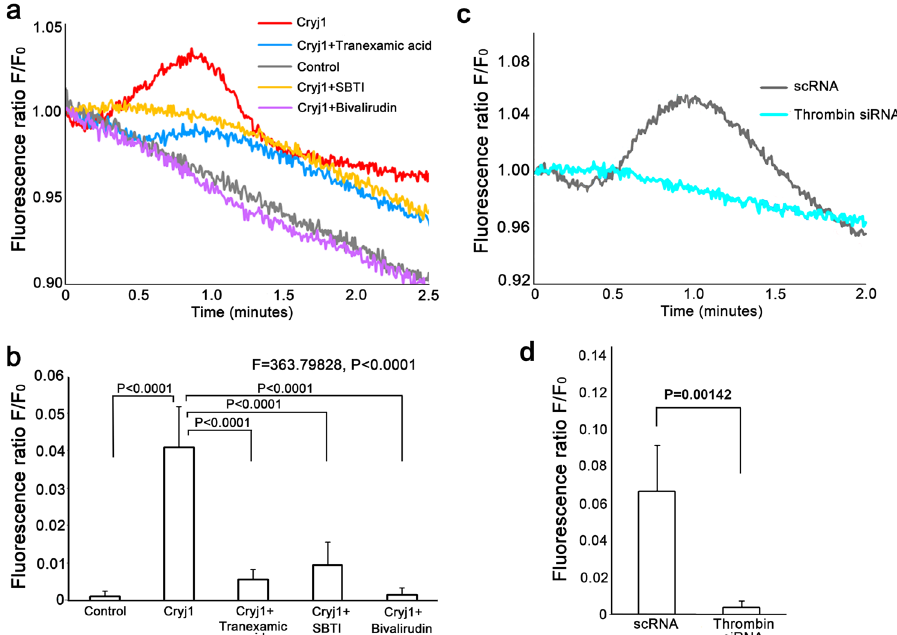
Figure 3. Protease activity of keratinocytes treated with Cry j1 with or without tranexamic acid, SBTI and bivalirudin. ( a ) Application of Cry j1 (100 ng/ml) to cultured human keratinocytes at time 0 s induced a rapid, transient increase of protease activity (red line). After application of BSS( + ) alone (control), the fluorescence level gradually decreased (gray line). The transient increase was blocked by tranexamic acid (blue line), SBTI (yellow line) or bivalirudin (purple line). The vertical scale is normalized by the fluorescence at time 0. ( b ) Quantitation of fluorescence change within 1 min after application (n = 30–50 cells). A significant difference was observed between the control and Cry j1 application groups. Tranexamic acid, SBTI and bivalirudin each blocked the increase. Similar results were obtained in three independent experiments. Bars and lines represent mean ± SD. ( c ) Application of Cry j1 (100 ng/ml) to the cells treated with scramble RNA at time 0 s induced a rapid, transient increase of protease activity (gray line), while the application of the same amount of Cry j1 to the thrombin siRNA-treated cells induced a low transient increase (cyan line). The vertical scale is normalized by the fluorescence at time 0. ( d ) Quantitation of fluorescence change within 1 min after application (n = 30–50 cells). A significant difference was observed between the thrombin siRNA-treated cells and control. Similar results were obtained in three independent experiments. Bars and lines represent mean ±